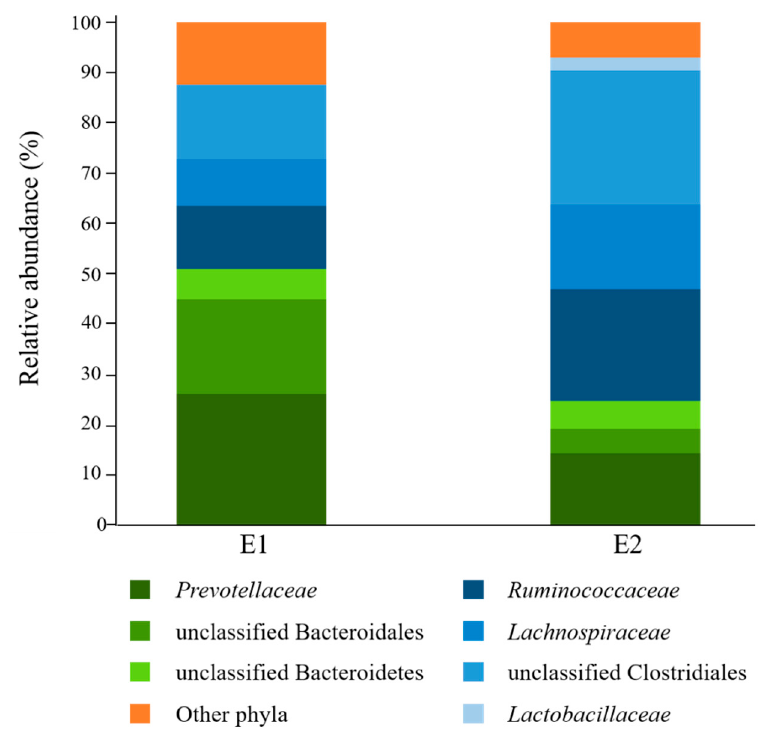
Figure 1. Family-level taxonomic composition of ruminal bacterial communities of the rumen fluid donors (E1, n = 1; E2, n = 1) used in this study. Families belonging to the same phylum are represented by different shades of the same color (Bacteroidetes: green; Firmicutes: blue). E1: D0 sample from Experiment 1; E2: D0 sample from Experiment 2. Table 1. Relative abundance of the ten most highly represented ruminal bacterial operational taxonomic units (OTUs) from the rumen fluid donors used in this study (D0). Abundance is presented as a percentage (%) of the total number of quality-filtered reads per sample. OTU Donor E1 Donor E2 Closest Valid Relative